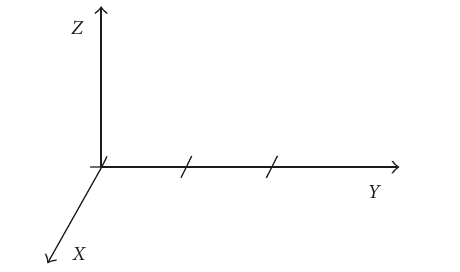
Figure 1: The structure of polarization sensitive array.